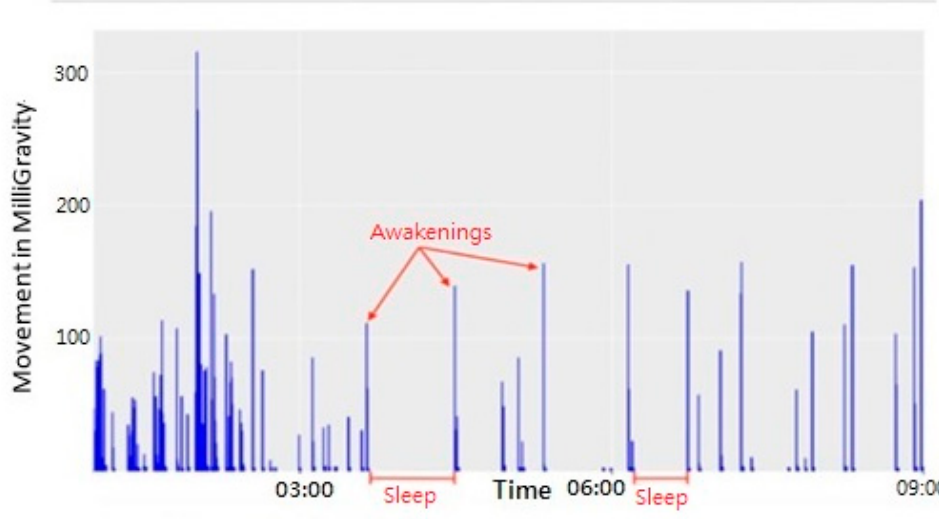
Figure 1. Movement data during sleep.